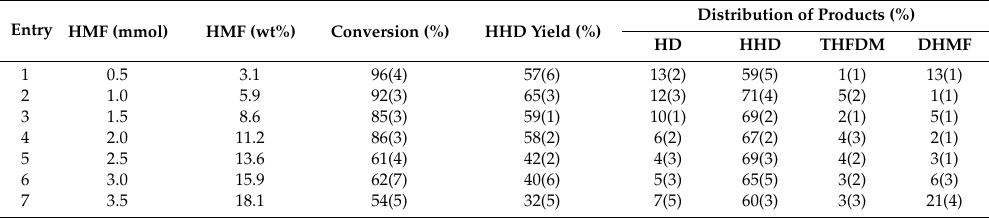
Table 3. The influence of concentration on the hydrogenation of HMF a .